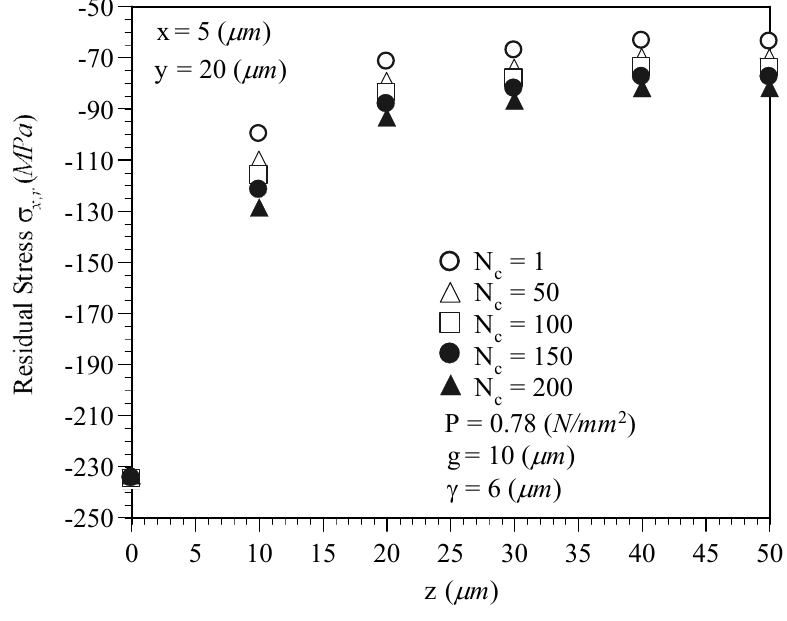
σ on the top surface x,r